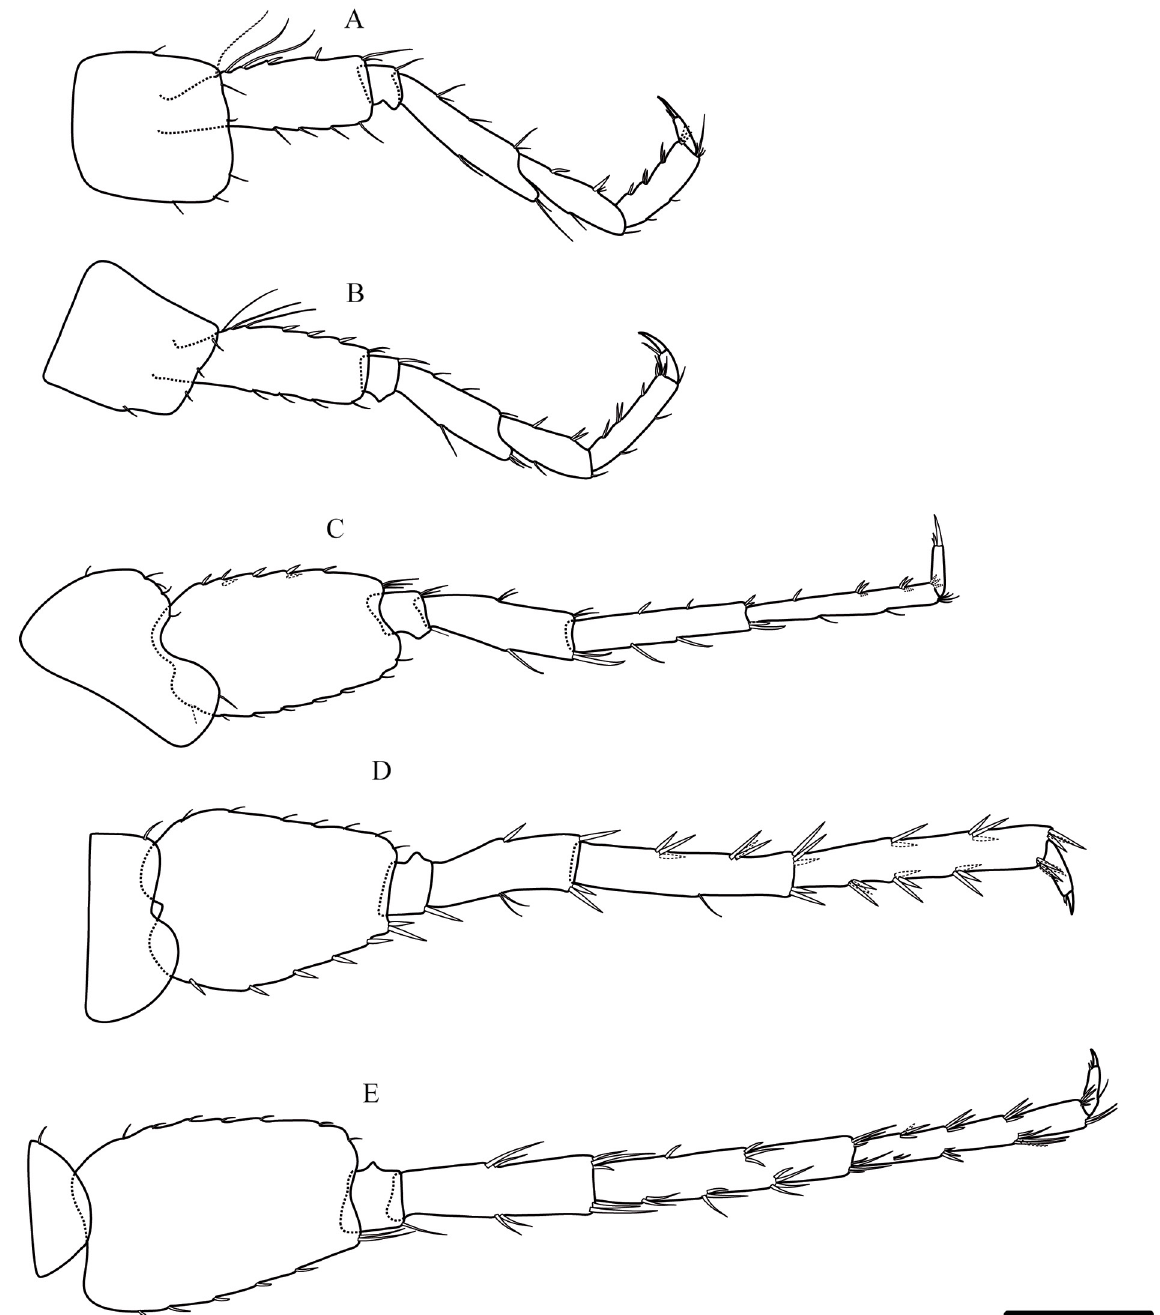
Fig. 5. Niphargus urmiensis sp. nov., holotype, ♂, 8 mm (ZCRU Amph.1071). A . Pereopod III. B . Pereopod IV. C . Pereopod V. D . Pereopod VI. E . Pereopod VII. Scale bar: 1